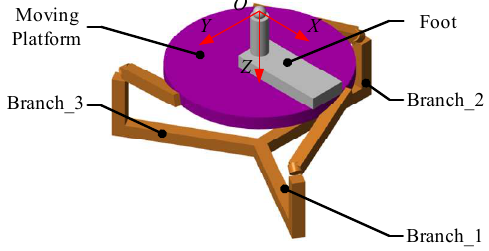
Figure 8. Simulation model of the PARR system.